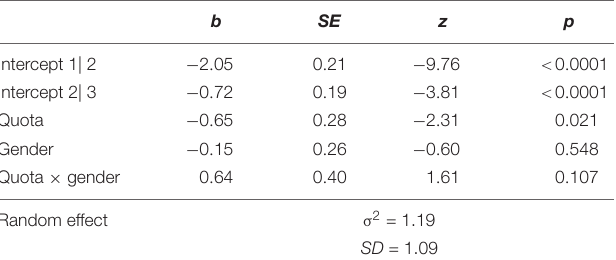
TABLE 3 | Multilevel ordinal logistic regression on the valence of the free verbal associations. b